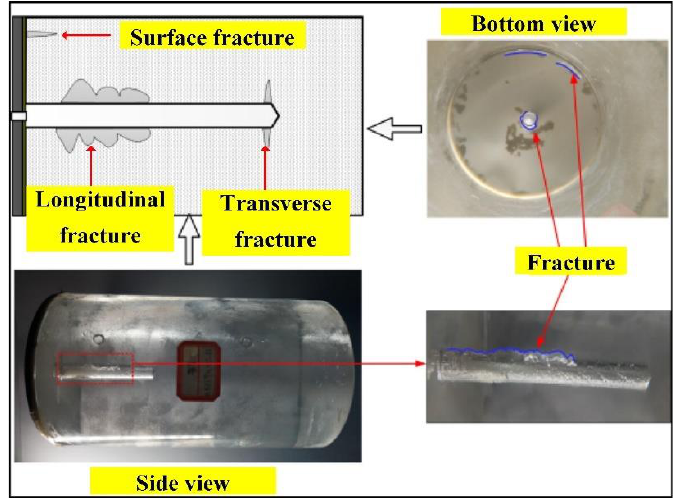
Figure 16. Fracture types in the experiment of Cai et al. [12] (modified).